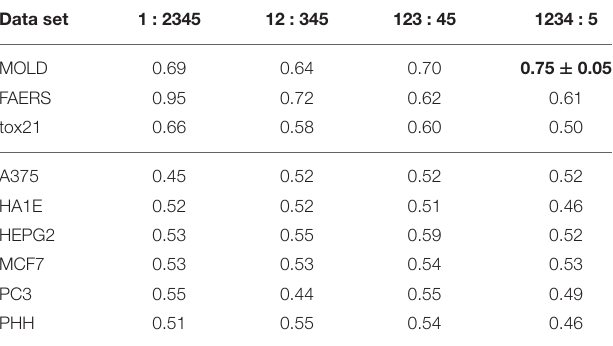
TABLE 6 | AUC for different binary decisions based on market status of the compound. Data